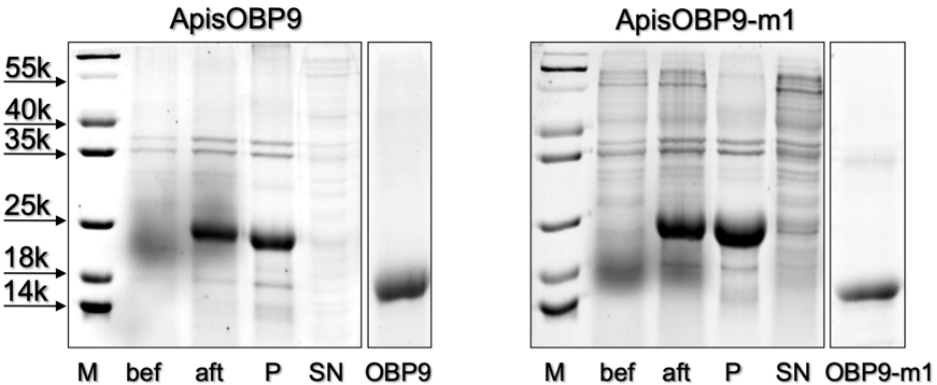
Figure 1. Expression and purification of ApisOBP9 and its mutant ApisOBP9-m1 (K37L). Samples before (bef) and after (aft) the induction with IPTG were centrifuged and the pellets dissolved in sample buffer and analyzed by SDS-PAGE. P and SN refer to samples of the pellet and the supernatant after sonication and centrifugation. The analysis of the protein samples obtained after removal of His-tag and final purification are shown in the last lanes.